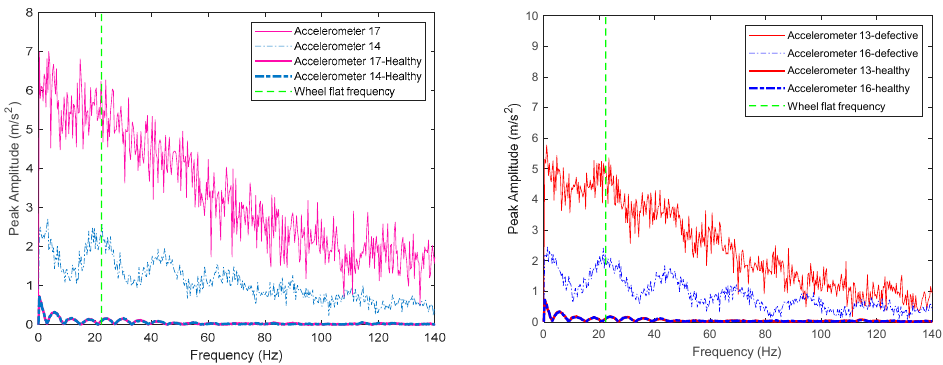
Figure 16. Optimization of the sensor layout.